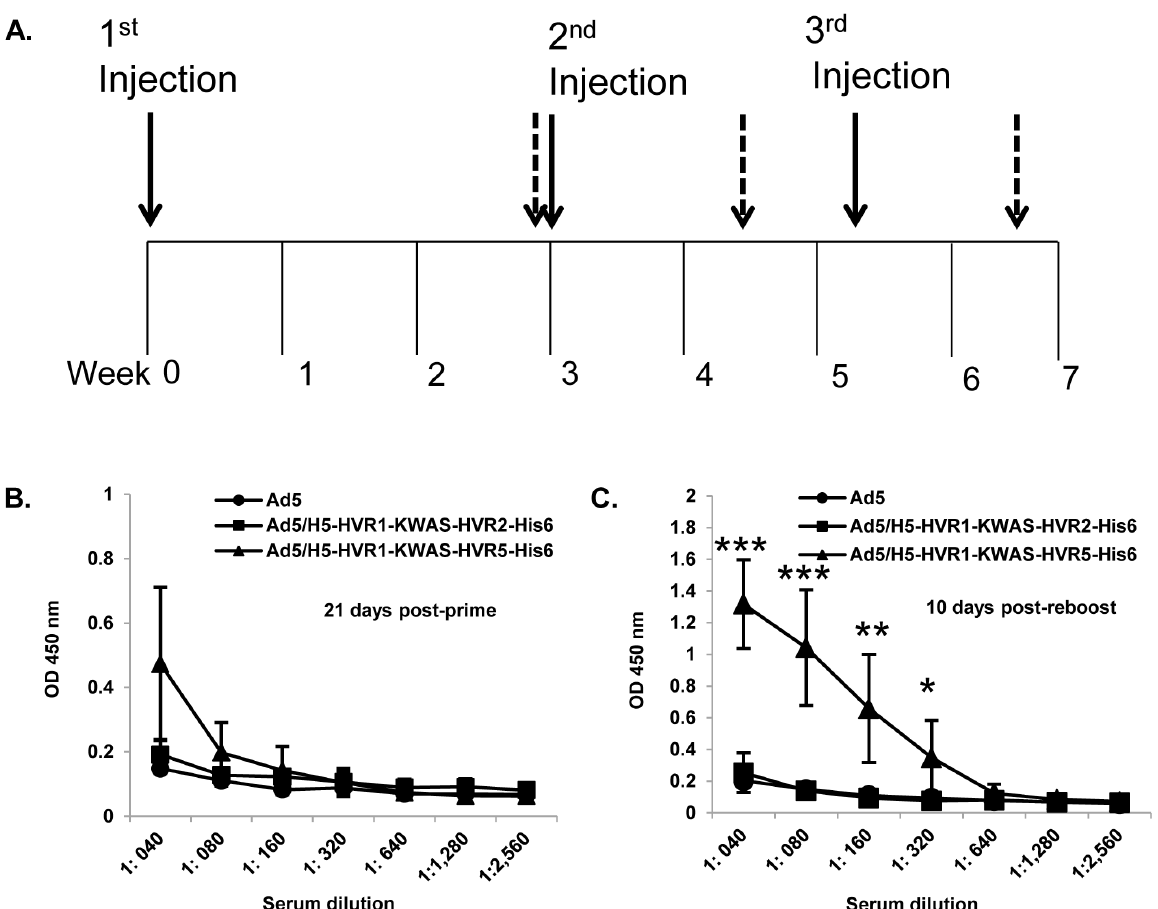
Figure 4. Multivalent vectors elicit an invivo anti-His 6 immune response. BALB/c mice (n=8) were primed, boosted, and reboosted with 1 6 10 10 VP of Ad vectors. A) Immunization timeline showing when immunizations were performed (solid arrows); serum was collected (dashed arrows). B–C) Post-prime and post-reboost serum was collected for ELISA binding assays. 1 m M of purified His 6 (LGSHHHHHHLGS) antigenic peptide was bound to ELISA plates. Residual unbound peptide was washed from the plates. The plates were then incubated with varying concentrations of immunized mice serum and the binding was detected with HRP conjugated secondary antibody. OD absorbance at 450 nm represents His 6 antibody levels in serum. The values are expressed as the mean 6 standard deviation. The asterisks (***) indicate a P value # 0.001, ** indicate a P value # 0.01, and * indicate a P value # 0.05.